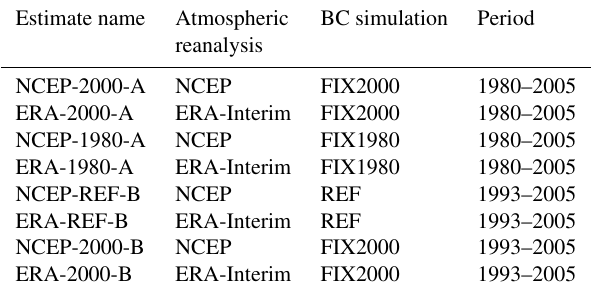
Table 1. Combination of atmospheric reanalysis, global chemistry– climate model simulations and time periods used to generate MLE of BC deposition and load.